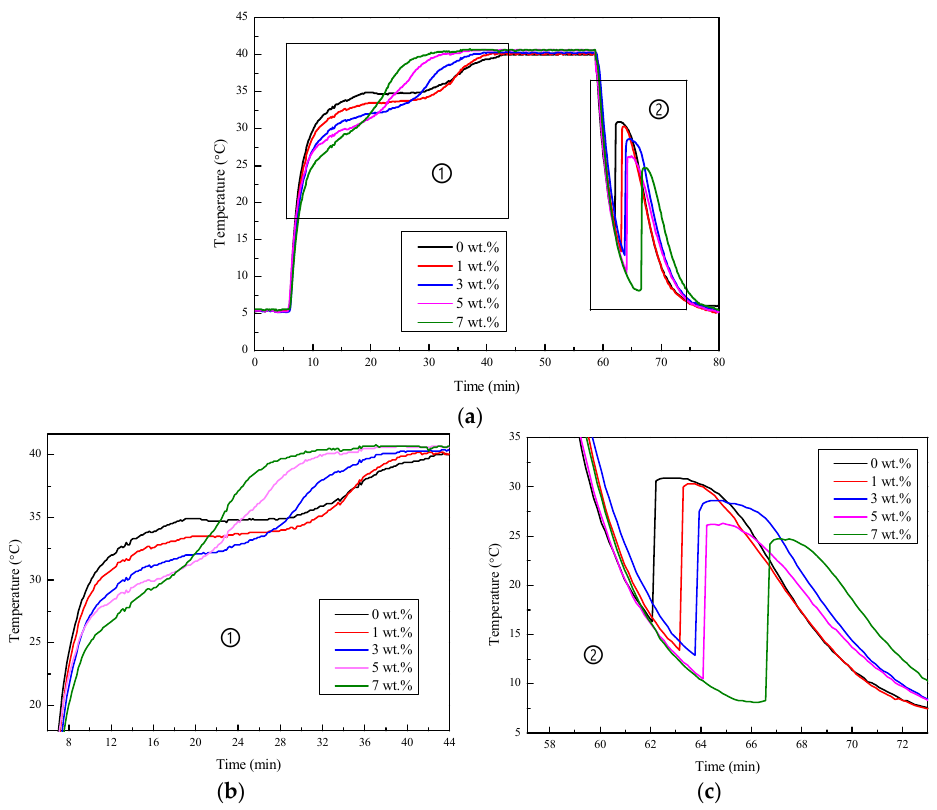
Figure 1. DSC curves of the Na 2 SO 4 ·10H 2 O–KCl eutectic mixtures with varying contents of KCl.